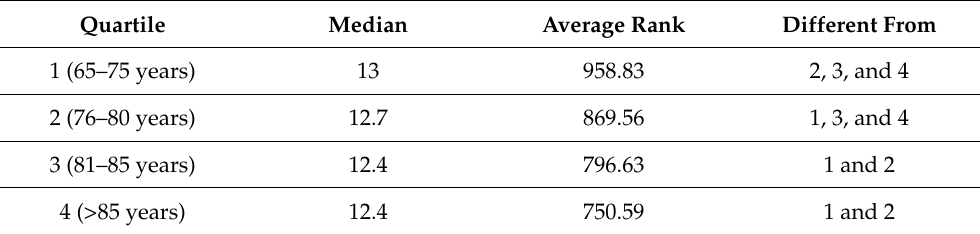
Table 10. Kruskal–Wallis and Conover